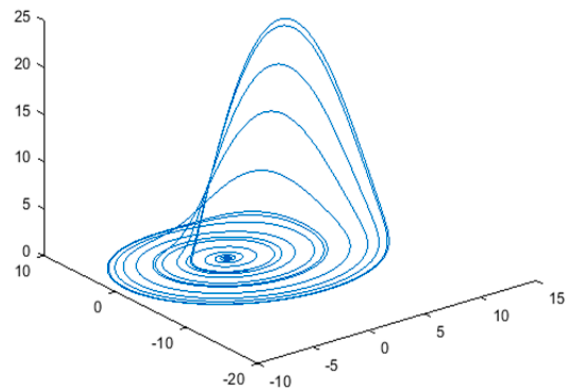
Figure 2. Phase portrait of discrete-time chaotic Rossler system.